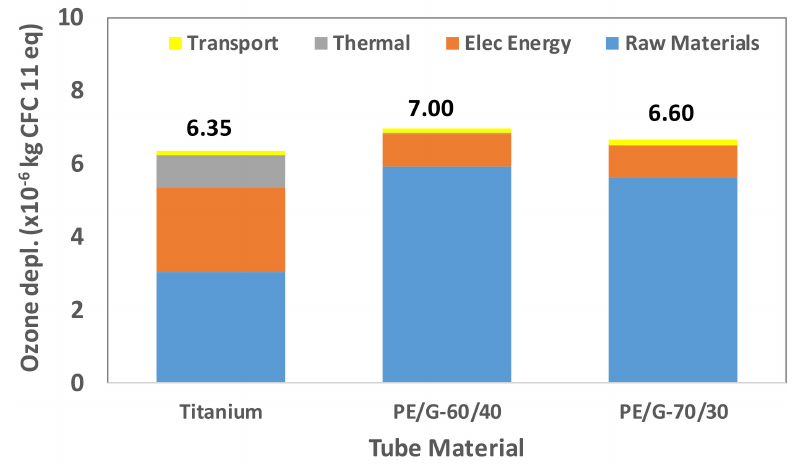
Figure 10. Ozone layer depletion (OD) for titanium and polymer tubes.